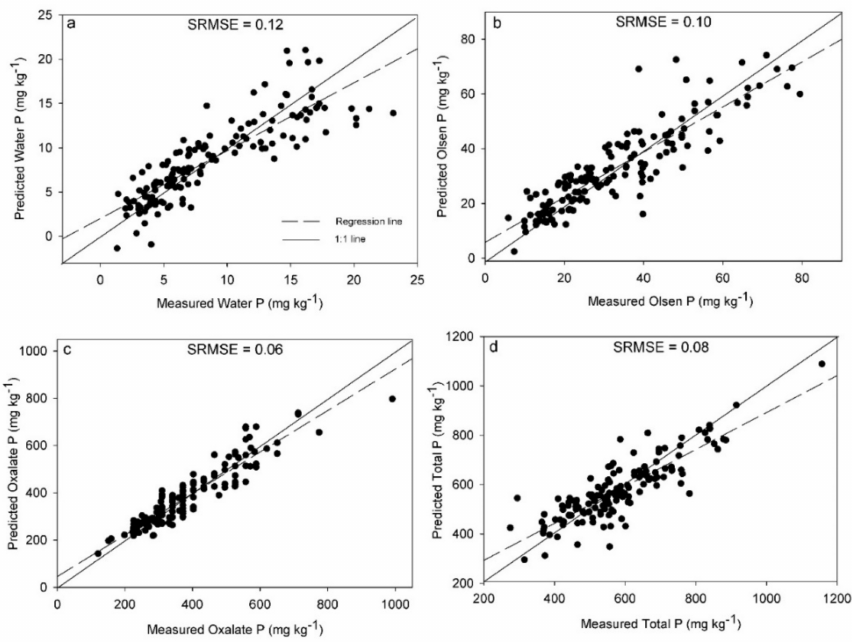
Figure 1. Partial least squares regression and variable selection results of the best laser-induced breakdown spectroscopy (LIBS) models, presented as the predicted versus reference measurements for water-extractable P ( a ), Olsen P ( b ), Oxalate-extractable P ( c ) and total P ( d ) measurements. Standard root mean square error of cross validation (SRMSE) is also included in each subplot.